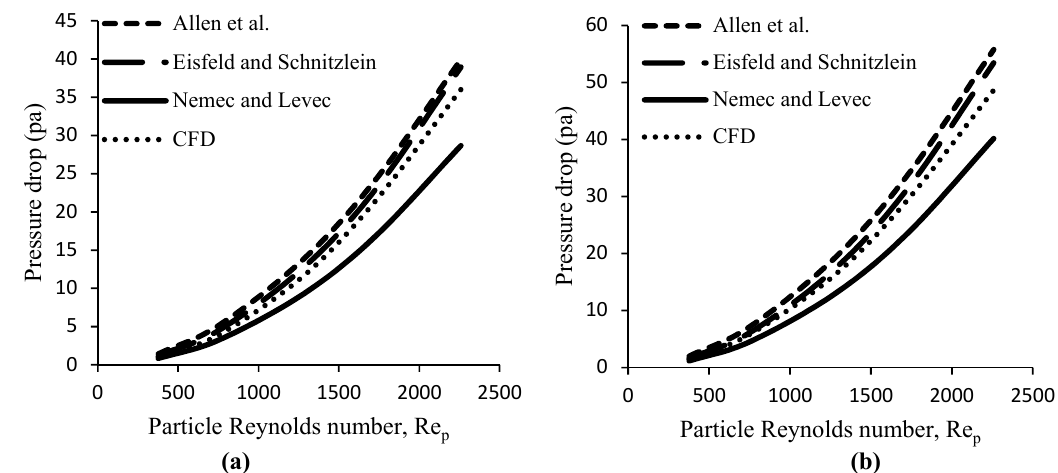
Fig. 10. Comparison of CFD pressure drop with empirical correlations for the packed bed with truncated cone particles in turbulent flow: a) N=6.52 and b) N=9.82.